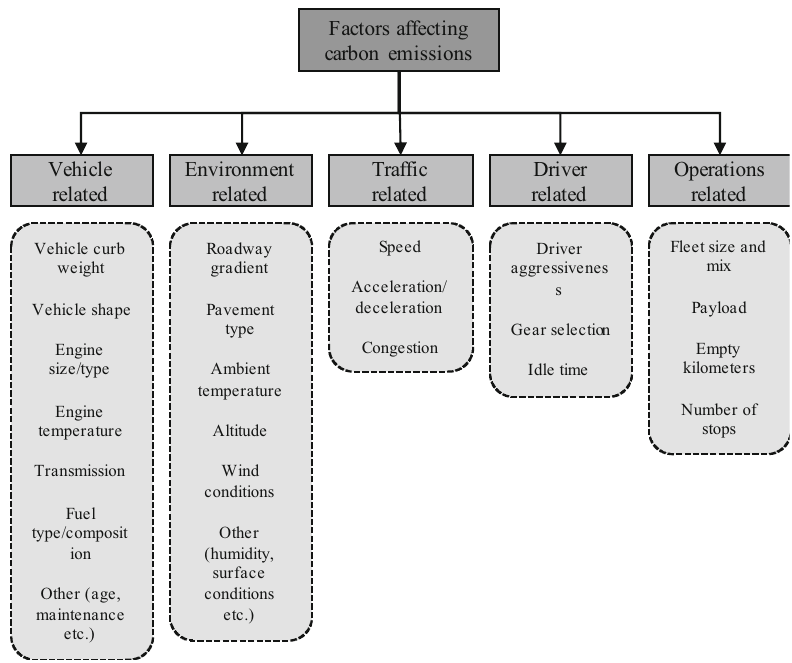
Fig. 1 Factors affecting carbon emissions. Source: